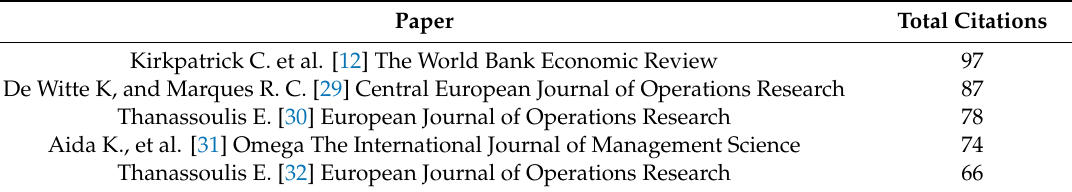
Table 2. Most cited papers.